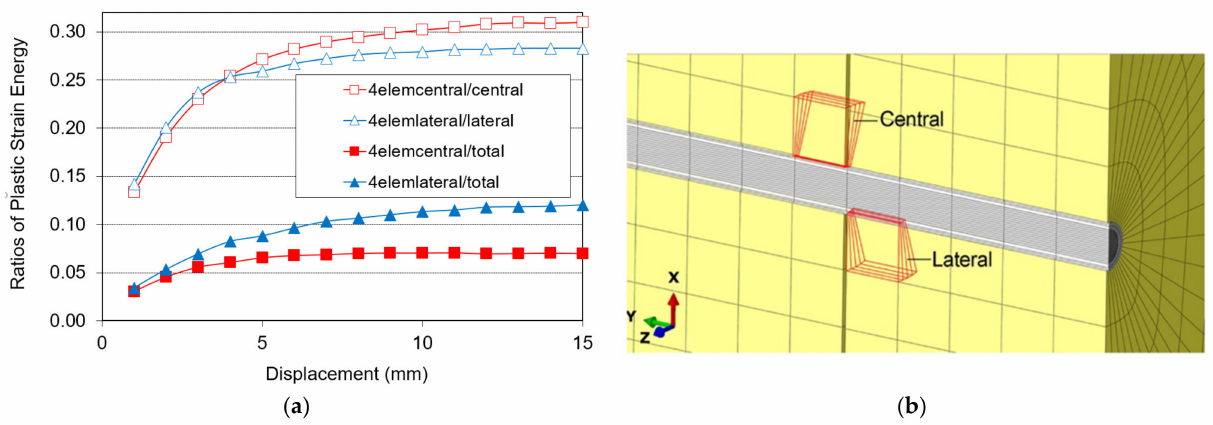
Figure 16. Ratios of plastic strain energies vs. displacement ( a ) between the high plastic-deformed corner elements represented on the right ( b ) and the whole joint and each timber